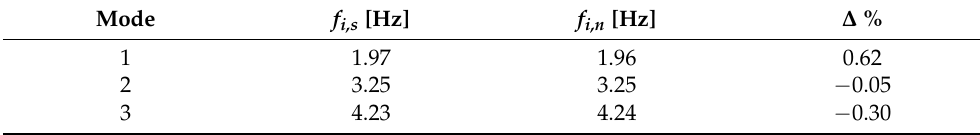
Table 12. Comparison between experimental eigenfrequencies of the steel frame and the correspond- ing numerical ones with the best value of the k x , k z 1 , and k z 2